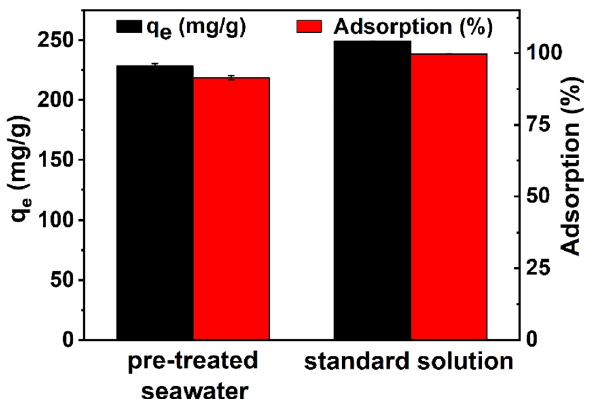
Figure 10. Application in adsorption of U(VI) from pre-treated